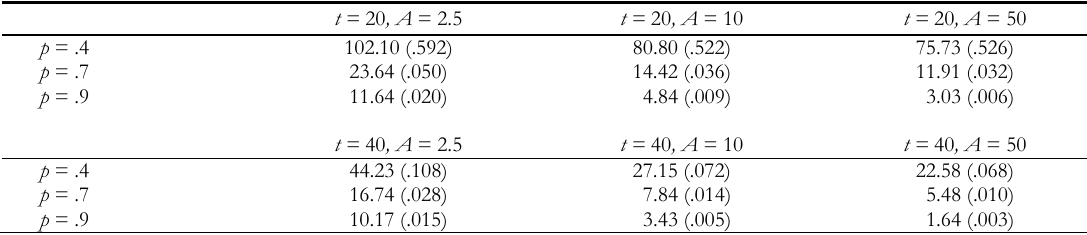
MSE ( (cid:79) (cid:4) ) for the calibration sample scenario t = 20 , A = 2.5 t = 20 , A =